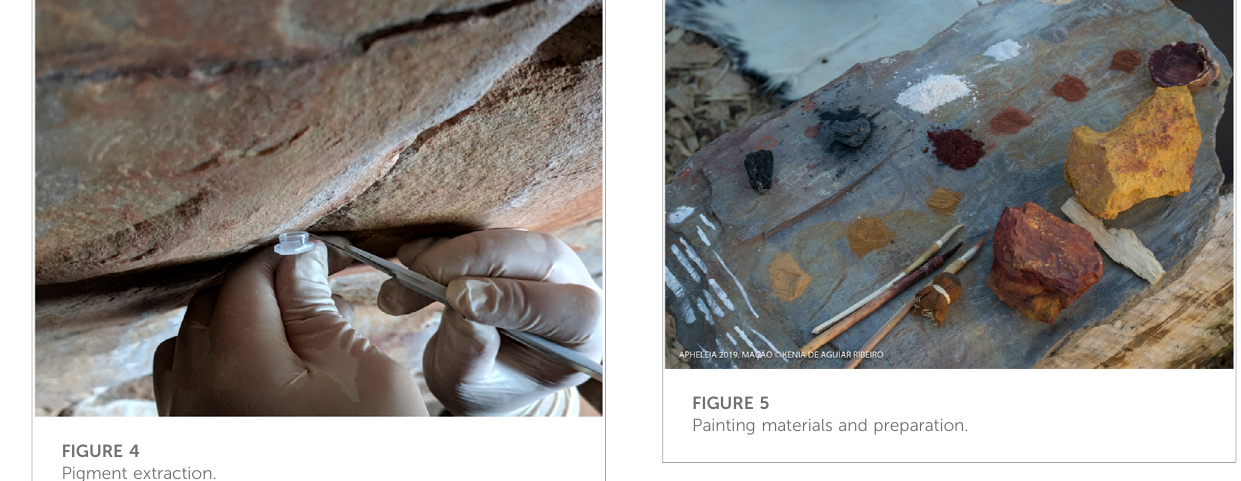
FIGURE 4 Pigment extraction.